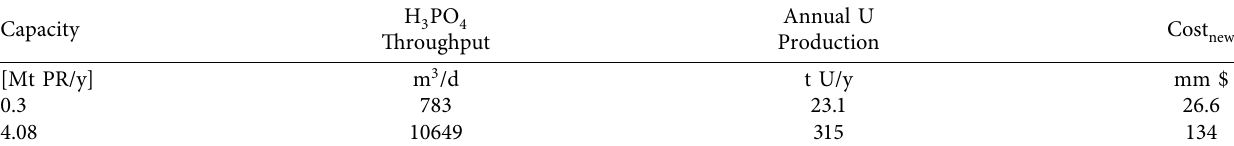
Table 4: Capital costs of U recovery units in